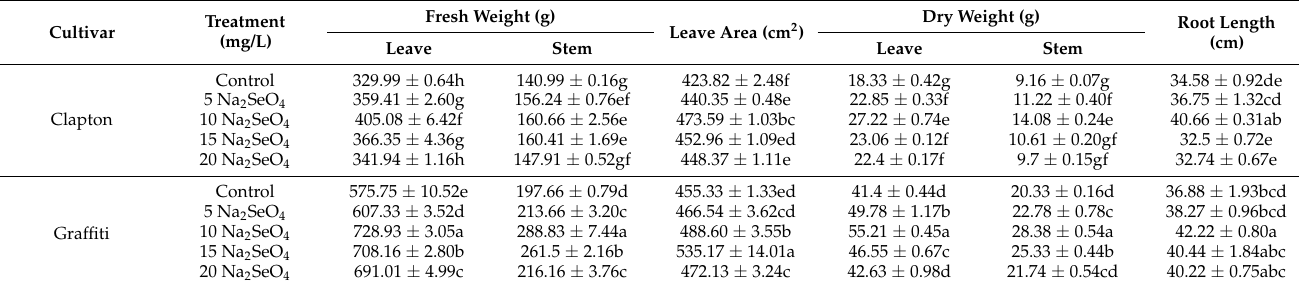
Table 2. Mean comparison of sodium selenate (Na 2 SeO 4 ) treatment on growth traits of the Cauliflower cultivars “Clapton” and “Graffiti”. In each column, same letters are not significantly different at the 1% and 5% levels based on Duncan’s multiple range tests with three